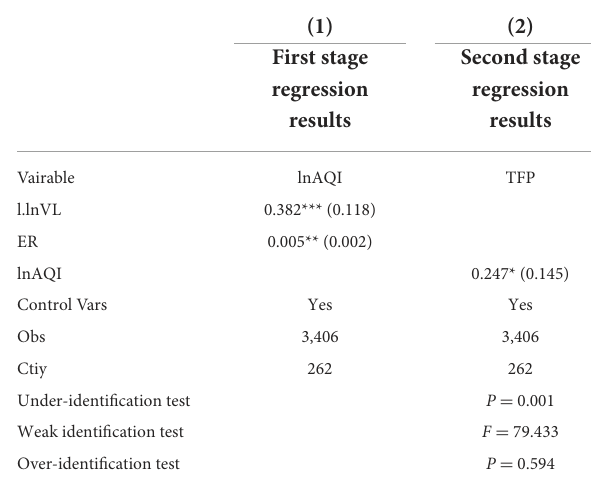
TABLE 9 Instrumental variable regression